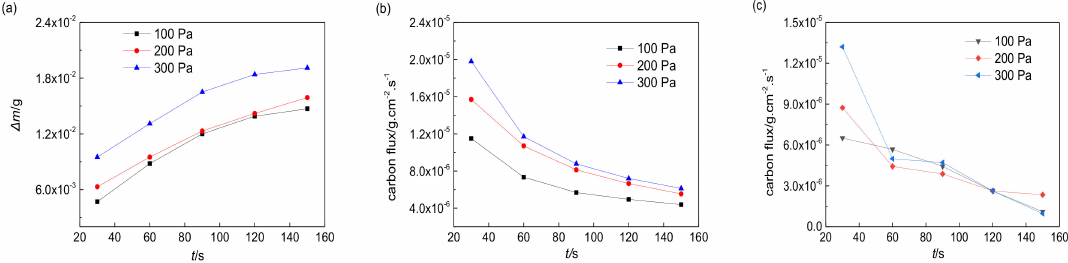
Figure 9. E ff ect of carburizing pressure on ( a ) mass increment, ( b ) average carbon flux, and ( c ) segmented average carbon flux of 18Cr2Ni4WA